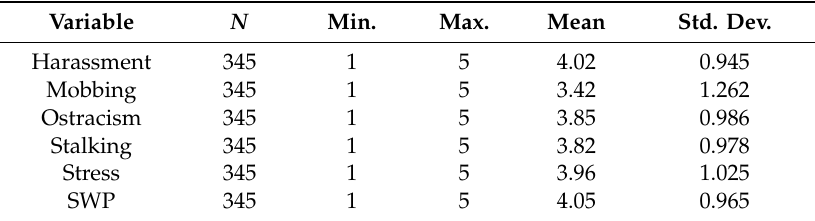
Table 5. Descriptive